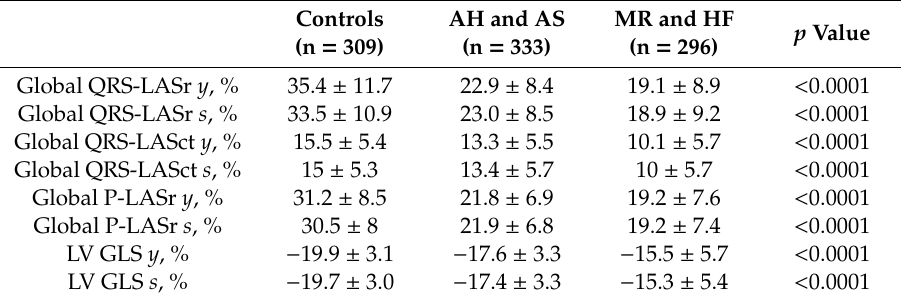
Table 3. Speckle tracking echocardiography parameters.